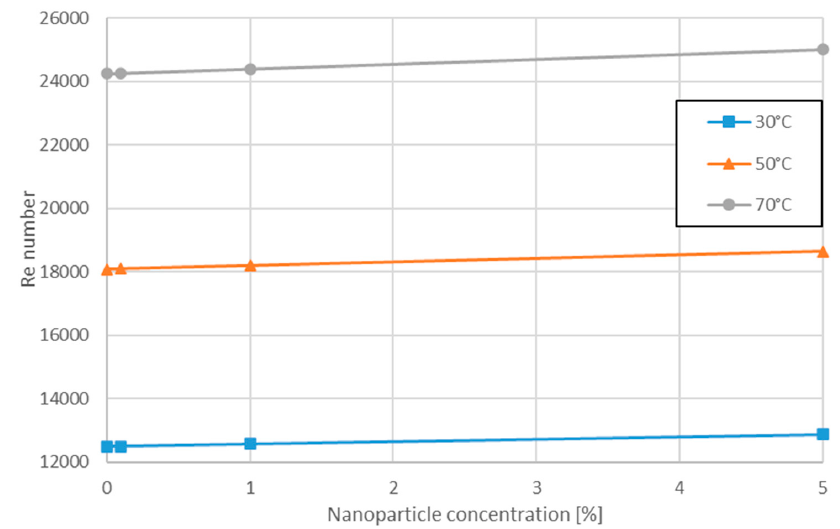
Figure 16. Variation of Re number for water-Al 2 O 3 nanofluids.